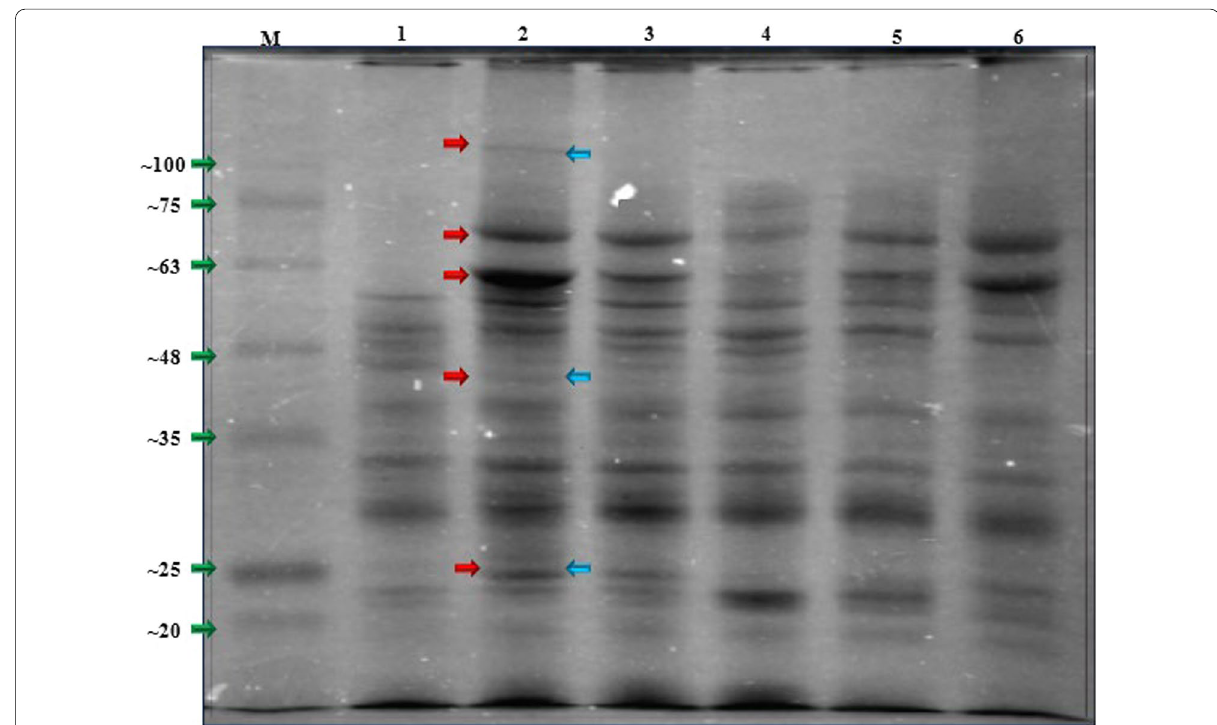
Fig. 5 The protein profile of snail under different concentration of CuNP: The 60 µg proteins were resolved on 12% SDS-PAGE analysis of protein extracts of Indoplanorbis exustus . Lane M protein ladder (11-245 kDa (kilodalton), Lane 1 = LC 50 ; Lane 4 1/5th of LC 50 ; Lane 5 1/3rd of LC 50 ; Lane 6 1/2th of LC = = =